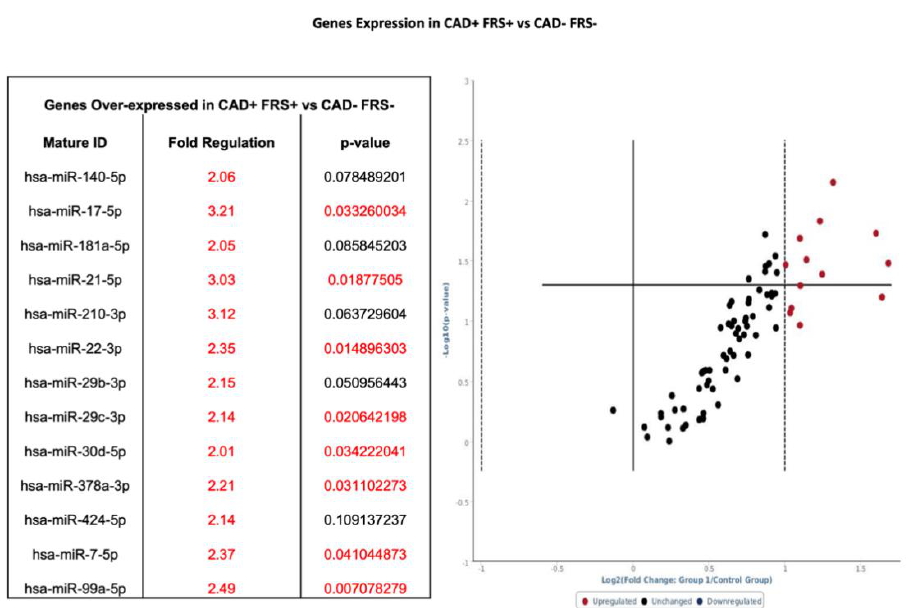
Figure 4. Volcano plot with corresponding table showing the comparison of miRNA assessed by microarray (84 genes) isolated from patients with CAD and FRS > 18 ( n = 9) versus heathy controls without CAD and FRS < 5 ( n = 9). Designation of significance (RED) was given to samples with fold change > 2. Samples with p values < 0.05 and fold change > 2 are found in the upper right quadrant. CAD—Coronary Artery Disease. FRS—Framingham Risk Score.